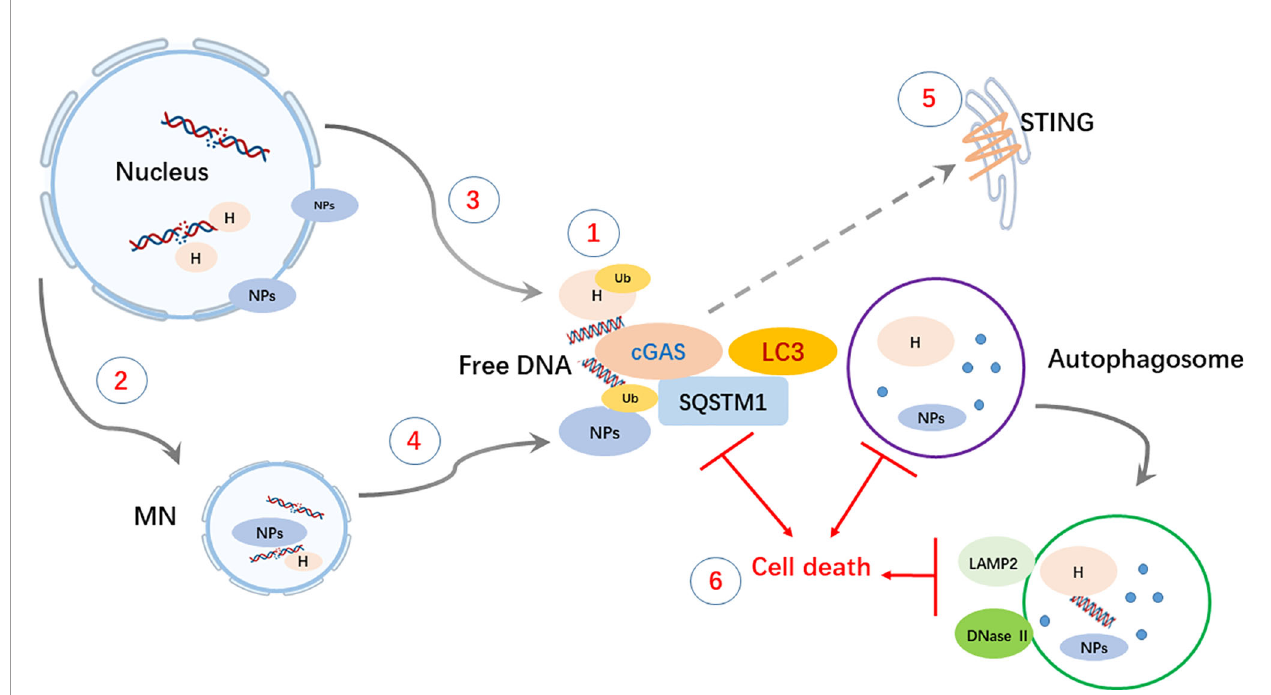
FIGURE 6 | Schematic summary of the main fi ndings. Cytoplasmic DNA autophagy is initiated by the binding of cGAS to free DNA and may be coordinately accompanied by the recognition of ubiquitinated Ub) histones H) or nuclear proteins NPs) by SQSTM1. ① Cytoplasmic DNA and proteins) could be derived from either DNA replication-related nuclear damage ② and consequent MN formation ③ , which would undergo collapse owing to its unscheduled replication ④ . ⑤ The degradation of STING could be involved in autophagy and result in a failure to activate SASP activity, but the role of STING in DNA autophagy still needs further exploration. ⑥ Generally, in autophagy, free DNA and proteins are enclosed in autophagosomes via LC3 lipidation and degraded after fusion with LAMP2- and DNase II-containing lysosomes. The clearance of cytoplasmic DNA by autophagy could play a protective role in maintaining the growth and survival of cancer cells, and thus, disruption of the process could lead to caspase-independent cell death